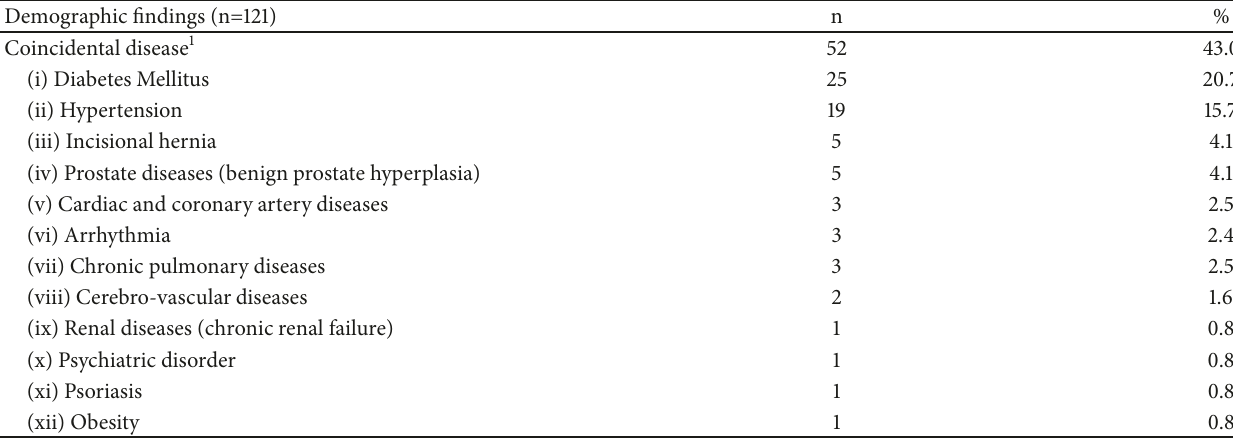
Table 1: Coincidental diseases in all